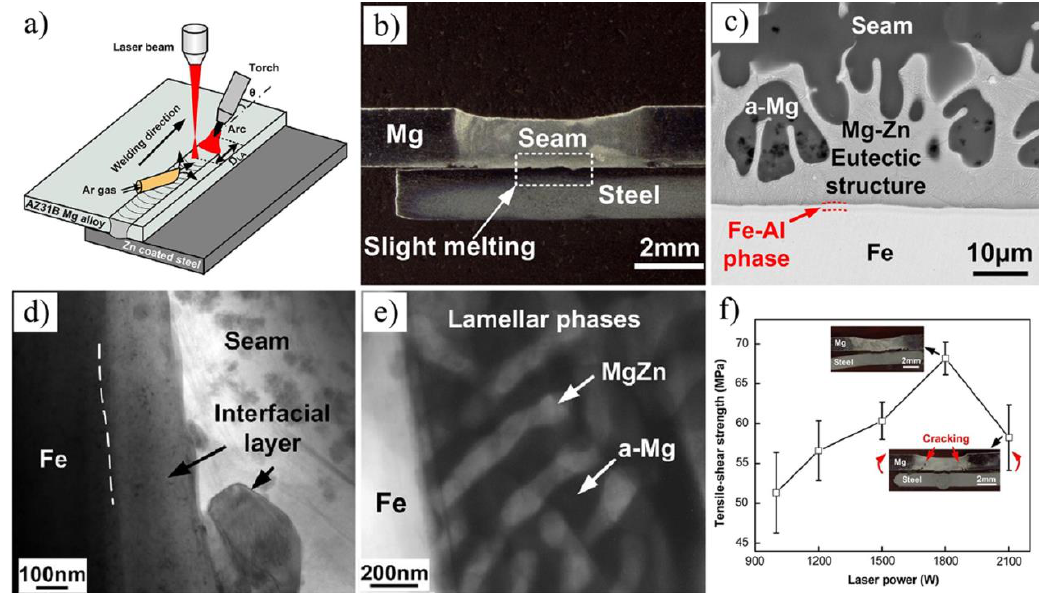
Figure 20. Mg/galvanized steel Laser-TIG hybrid welding process [66] ( a ) schematic diagram; ( b ) cross-section photograph; ( c ) interfacial microstructure morphologies at 1200 W; ( d , e ) bright field micrograph taken at the interface and the seam; ( f ) tensile-shear strength versus laser power.